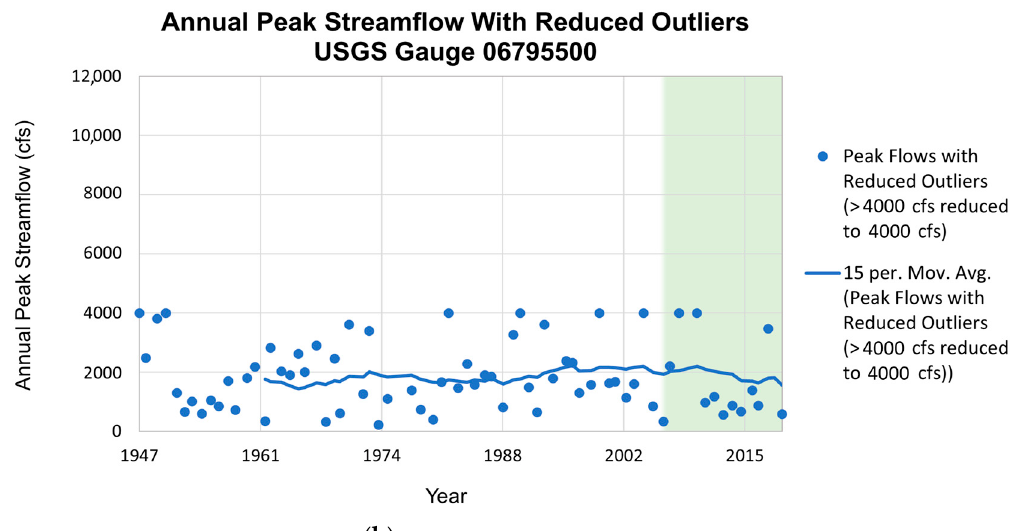
Figure 8. Unmodified and modified peak flow data for SCW, with the green section of each graph indicating the years of the post ‐ planning period. ( a ) Annual peak flow data for SCW are plotted in red points. The 15 ‐ year moving average for the data is indicated by a red line. ( b ) Annual peak flow data for SCW with outliers above 4000 cfs reduced to 4000 cfs is plotted above in blue points. The blue line indicates the 15 ‐ year moving average for the modified peak streamflow data.